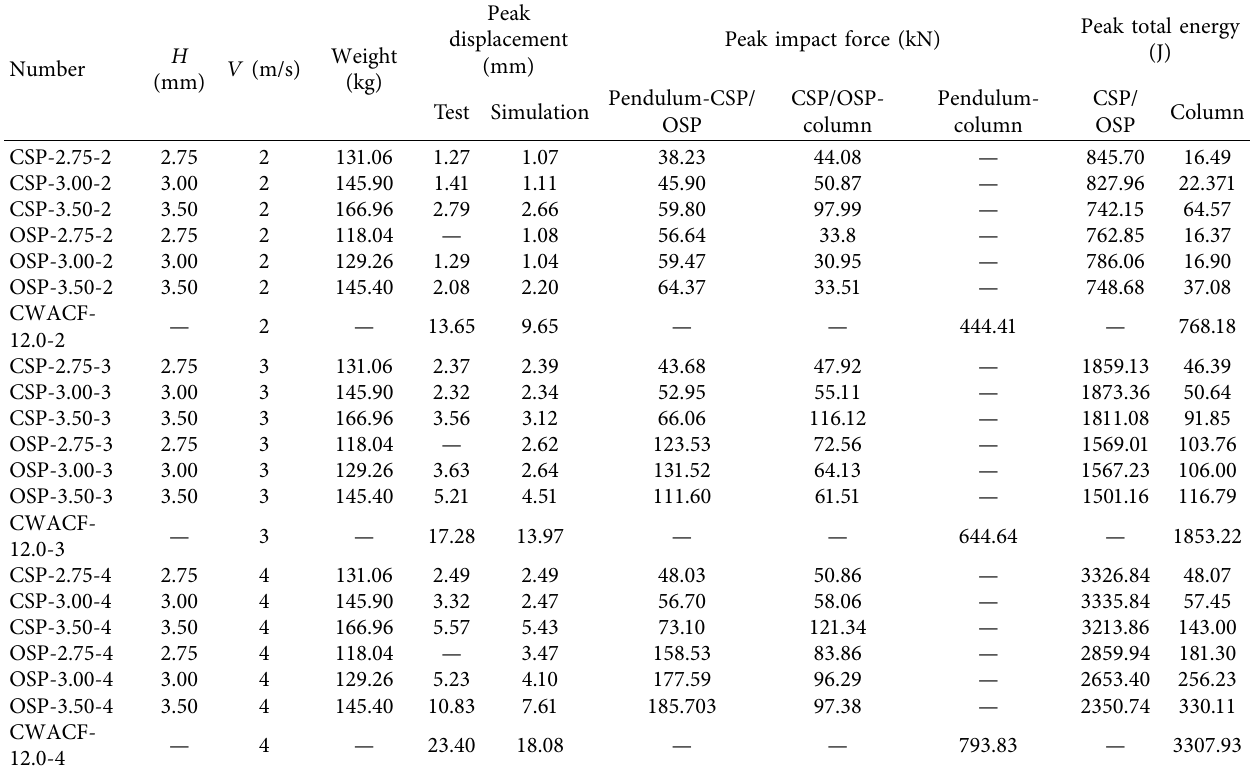
Table 3: Parameter